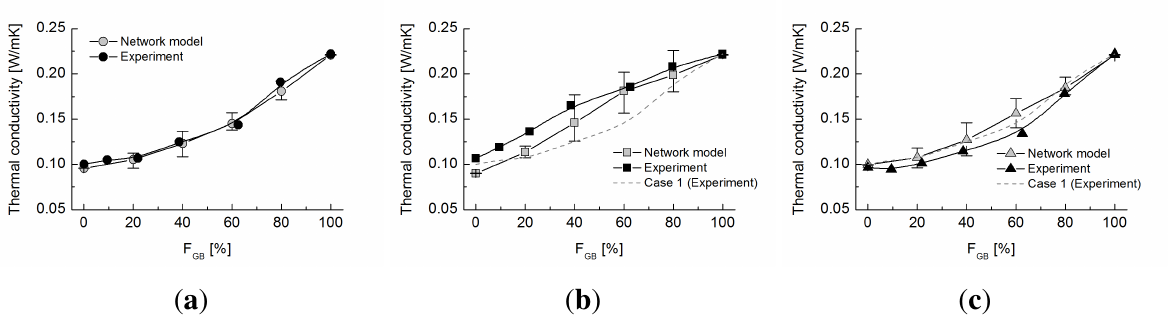
Figure 5. Thermal conductivity obtained by experiments and network model for Cases 1 to 3. ( a ) Case 1; ( b ) Case 2; ( c ) Case